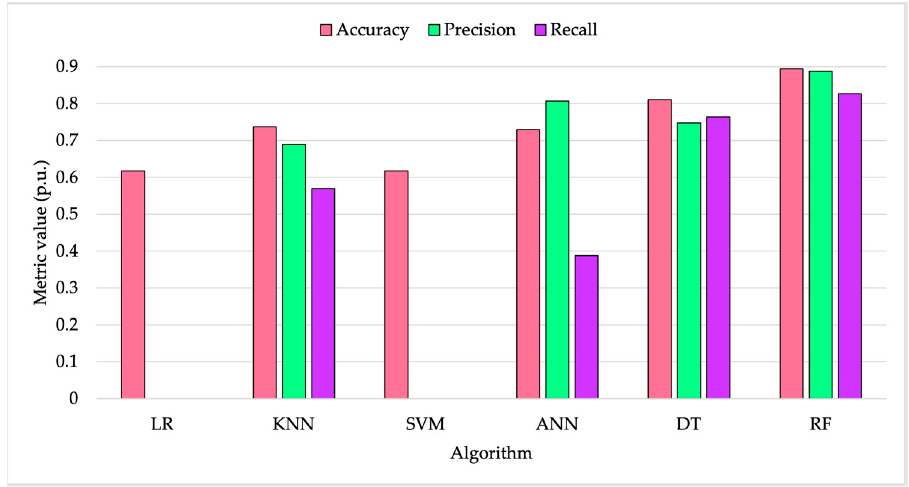
Figure 9. Algorithm metrics in the case of 1000 samples for the learning stage.